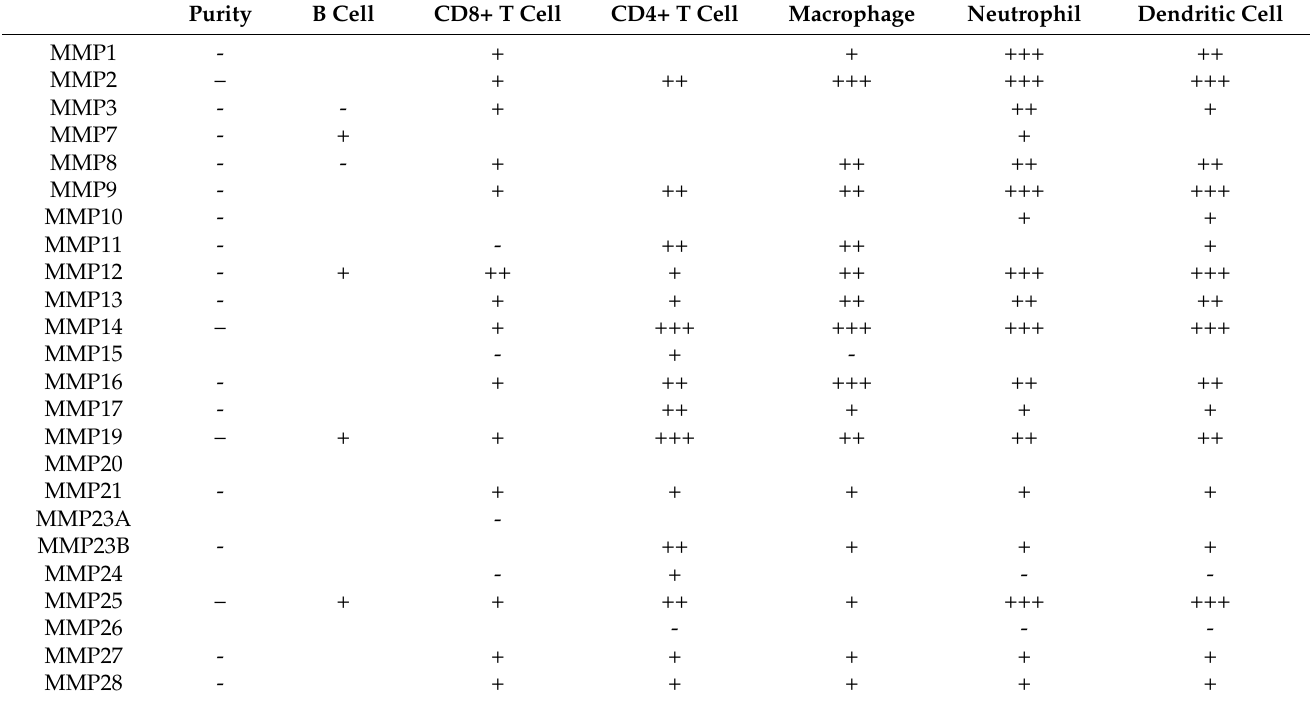
Table 4. Correlation analysis between MMPs and immune infiltration levels. The correlations between individual MMPs and tumor purity, MMPs and infiltration levels of six TIICs (B-cells, CD4+ T-cells, CD8+ T-cells, macrophages, neutrophils, and dendritic cells) were analyzed by TIMER in COAD. r, the categorized Pearson’s correlation coefficient, was scored as follows: (—), r from − 1.0 to − 0.5, strong negative association; (–), − 0.5 to − 0.3, weak negative association; (-), − 0.3 to 0.1, little association. (+), +0.1 to 0.3, little association; (++) +0.3 to +0.5, weak positive association; (+++), +0.5 to +1.0, strong positive